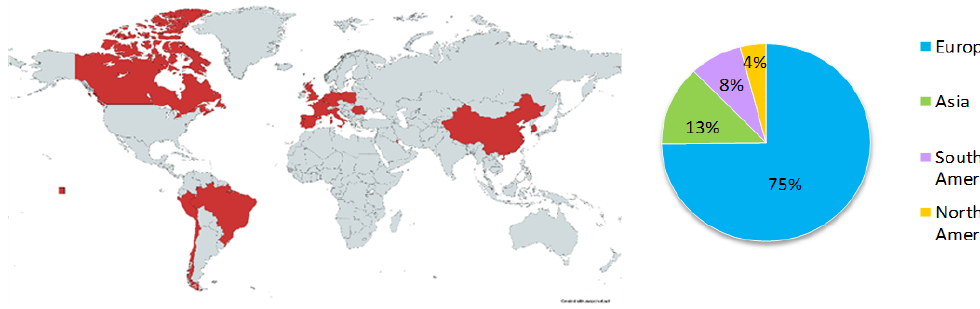
Figure 9. The distribution of the W.A.T.E.R. participants regarding the locations of their affiliations (cumulative results).